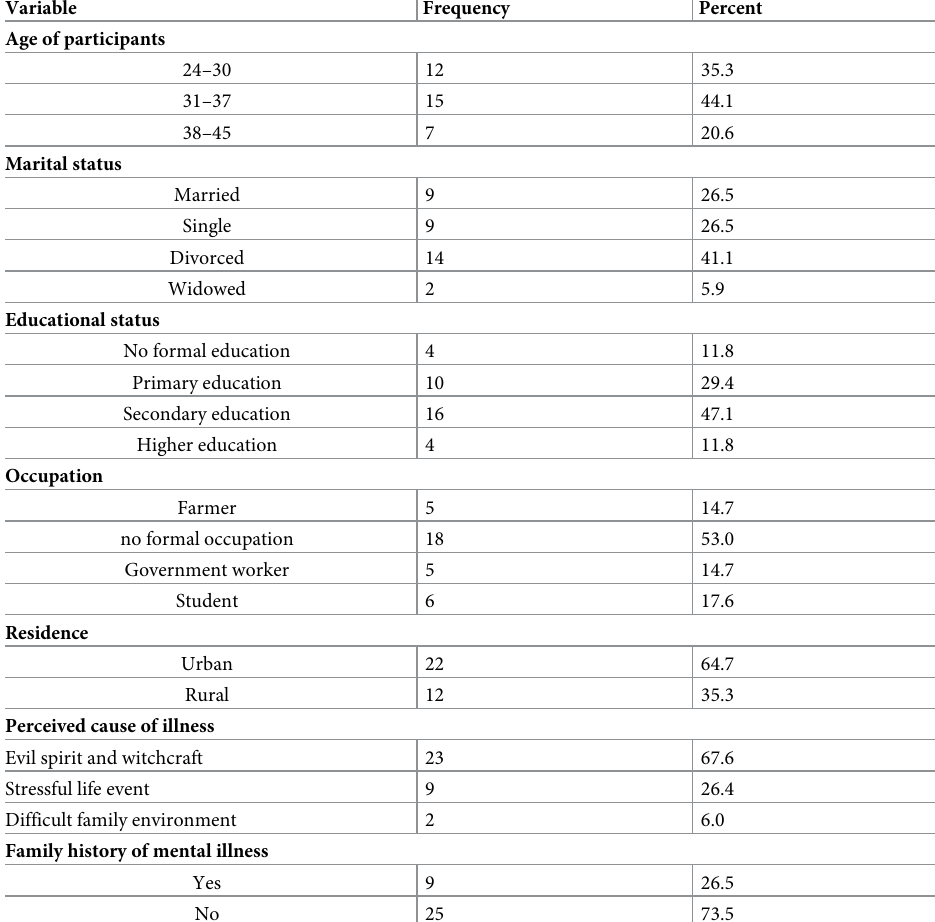
Table 1. Sociodemographic characteristics and clinical factors of study participants in Jimma medical center Southwest Ethiopia, 2019. (n =